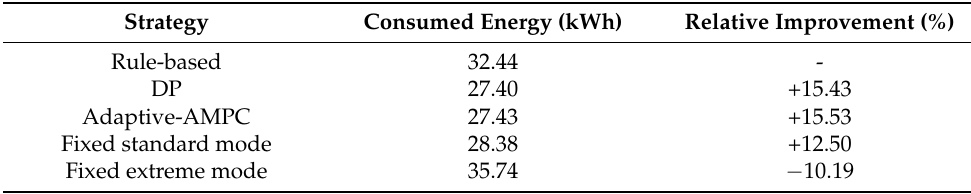
Figure 26. Magnified garbage residues. Compared TO the rule-based strategy, optimization methods such as DP and the AMPC decreased battery SoC more evenly. Particularly, each time a sanitation vehicle encountered segments marked level 4, the expended electric energy increased dramati- cally, which is highlighted in the enlarged red rectangle. As a result, more segments that were difficult to clean up occurred on the road, and more energy was “wasted” by the rule-based strategy. For two fixed working modes, on the one hand, it is appropriate that the extreme mode consumed the most energy. On the other hand, it seems that the stand- ard mode performed a little worse than DP but won on simplicity by making some sacri- fices on garbage residue.